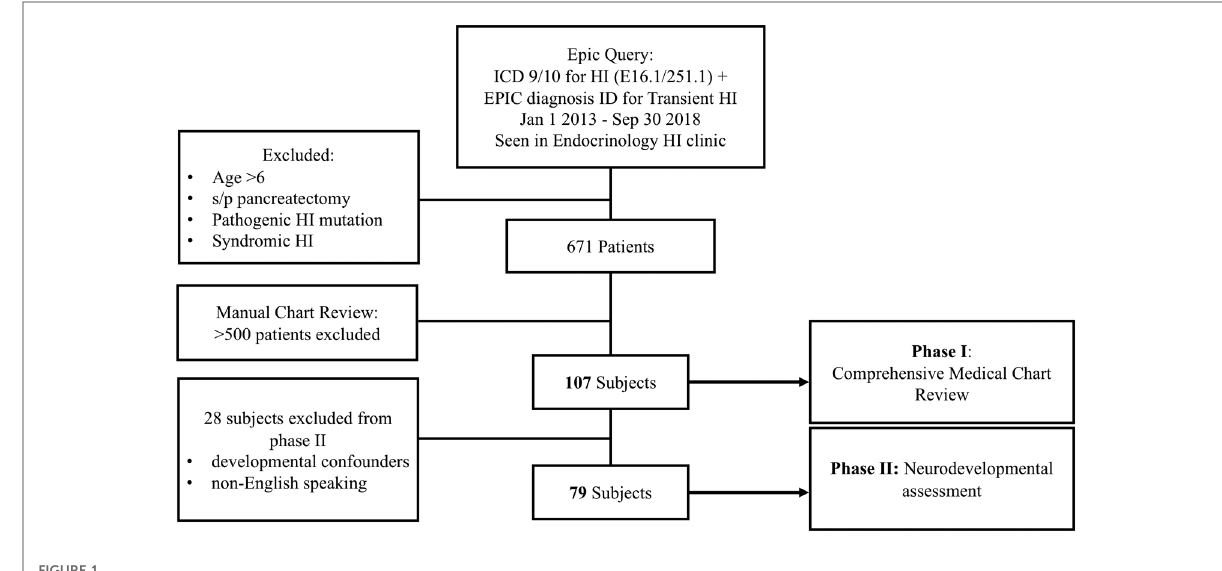
FIGURE 1 Subject identi fi cation and recruitment.